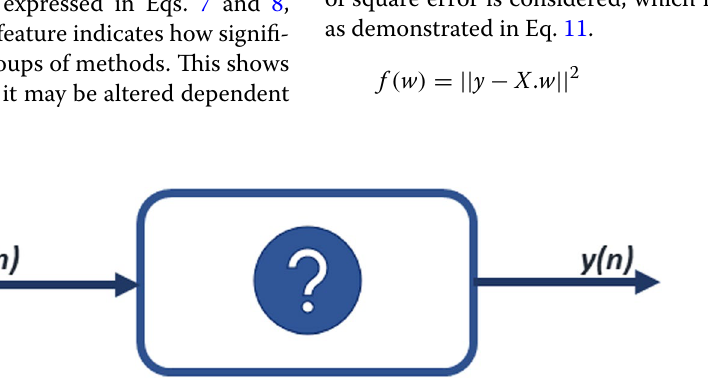
Fig. 4 Unknown relationship between “regressor” and